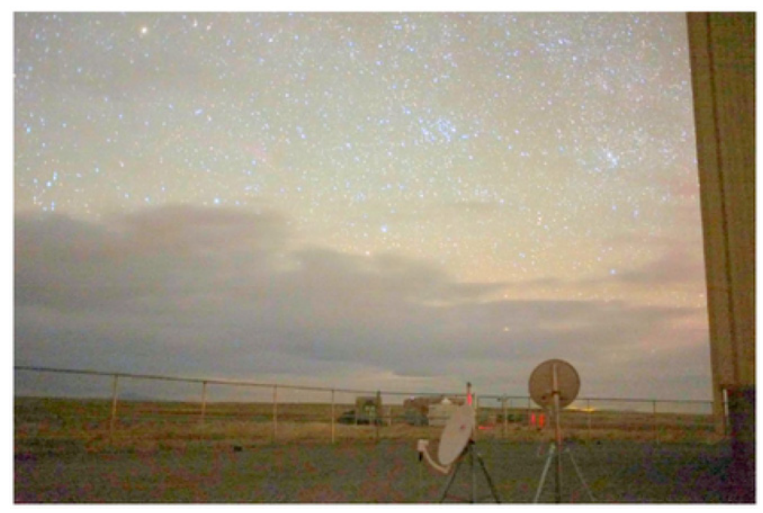
Figure 3. The two antennas are installed just beside the BRM station building. Behind the antennas and the fence the buildings for the electron accelerator called ELS are seen in this photo.